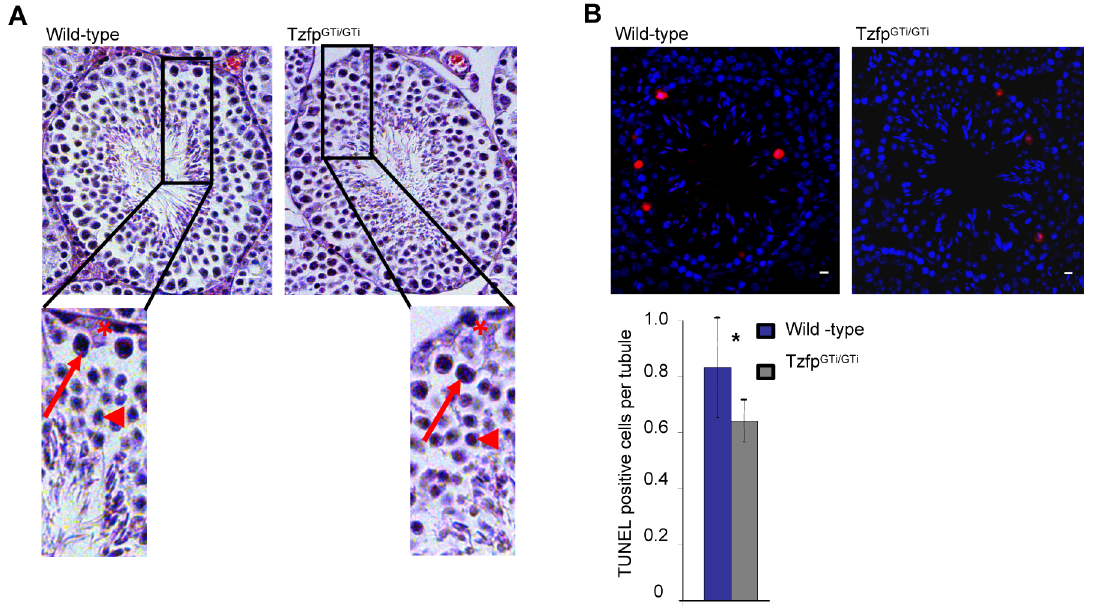
Figure 5. The Tzfp GTi/GTi testis develops normally but has a reduced number of apoptotic cells. (A) Stage VII-VIII tubules from wild-type (left) and Tzfp GTi/GTi (right) testis. Magnified areas show the presence of spermatogonia (star), pachytene spermatocyte (arrow) and round spermatid (arrowhead). Scale bar: 20 m m. (B) TUNEL assay performed on wild-type (left) and Tzfp GTi/GTi (right) testis sections. The histogram indicates quantification of positive cells. Statistical analysis was performed using the two-tailed Student’s t test: *p , 0.05; **p , 0.01; ***p ,